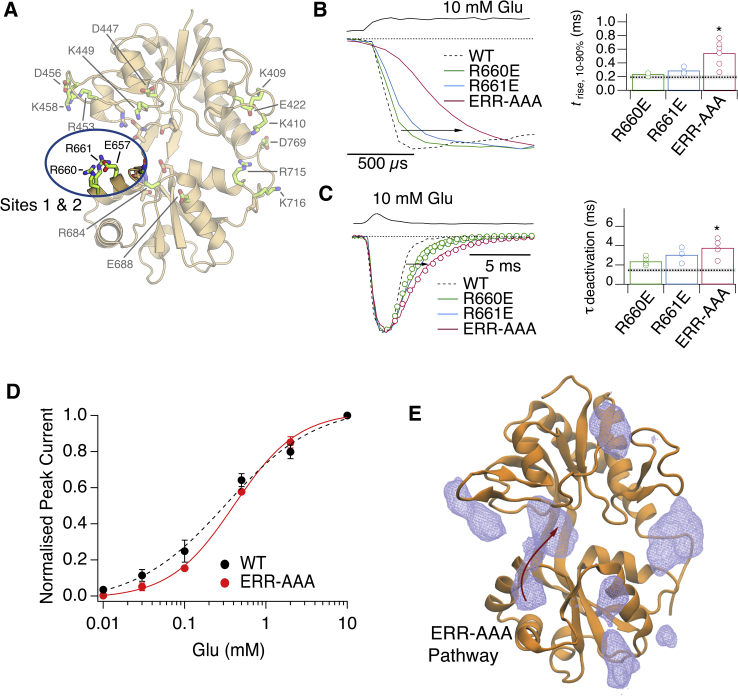
Activation and Deactivation of Receptors with Mutations in Pathways 1 and 2(A) Residues in Lobe 2 that interact with the ligand at metastable sites 1 and 2 (Figure 2B) include R660, R661, and E657 (blue oval). The following mutations were made to test these sites: R660E, R661E, and E657A-R660A-R661A (ERR-AAA).(B) Left panel shows activation of Lobe 2 mutants (R660E, green; R661, blue; ERR-AAA, red) in response to a long pulse of 10 mM glutamate. The individual 10%–90% rise times of the currents (trise) are shown in the bar chart in the right panel, with the WT mean value as a dashed gray line, with asterisk indicating p < 0.05 versus WT from t test.(C) Left panel shows deactivation of Lobe 2 mutants following a 1 ms pulse of 10 mM glutamate, with color coding as in (B). Individual rise times are plotted in the right panel.(D) The affinity for glutamate is unchanged for the ERR-AAA mutant relative to WT. Dose-response curves in glutamate, measured at the peak current response, for WT GluA2 (EC50 = 330 ± 90 μM; black circles), and for the mutant ERR-AAA (EC50 = 410 ± 30 μM, red circles). By comparing the fits to responses from individual cells, the glutamate EC50 for ERR-AAA was indistinguishable from that of WT GluA2 (p = 0.5; t test, n = 3).(E) The PMF for the ERR-AAA mutant, contoured at 2.62 kcal/mol. Data are from the monomeric LBD with 10 ligands (Tmut1-4). The PMF shows a loss of ligand density along Pathways 1 and 2, proximal to helix F. The ERR-AAA ligand-binding pathway, indicated by the red arrow, resembles Pathway 3 of the WT LBD. Interactions between R684 and R675 on Lobe 2 at site 4 are preserved in both the mutant and WT protein. These residues metastably interact with the ligand prior to binding in Tmut1.See also Figure S6, Tables S3 and S4, and Movie S4.